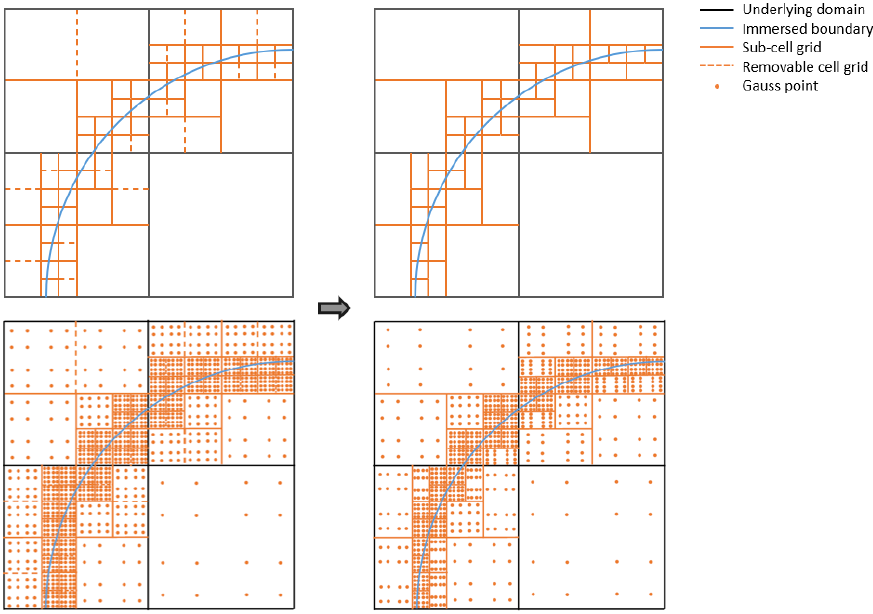
Figure 2. Illustration of sub-cell coalescence when removing non-intersected cell